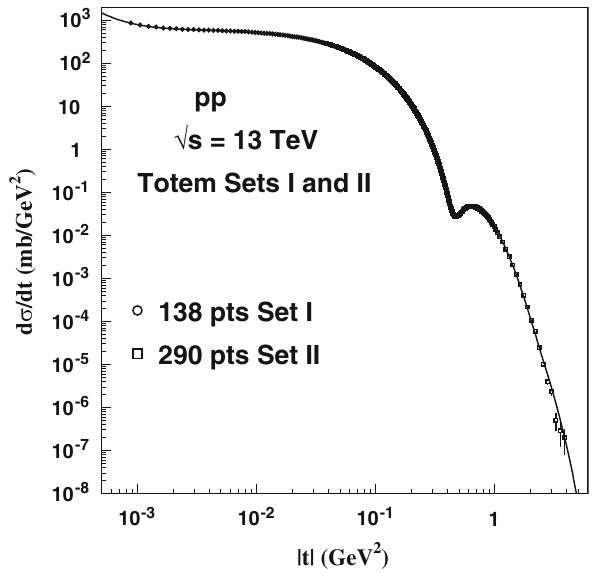
Fig. 1 Systematic errors in data Set I [1] and Set II [2]. In the | t | range with superposition (0 . 038400 ≤ | t | ≤ 0 . 201041) it seems that in general the data in Set II may be considered as more reliable (1% systematic errors), except for the first 11 points. Set I has 5% systematic error bars